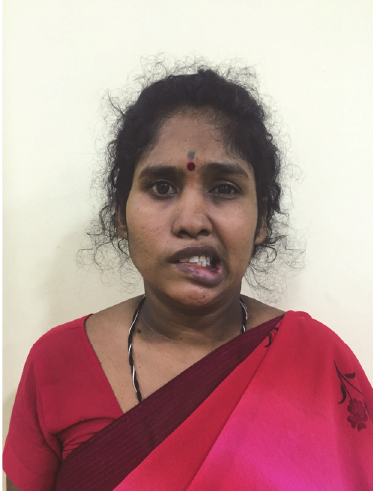
Figure 3: Contrast sagittal MRI shows well-defined heteroge- neously enhancing T1 hypo and T2 hyperintense mass in the right cerebellopontine angle causing mild mass effect on the brain stem (white arrow).